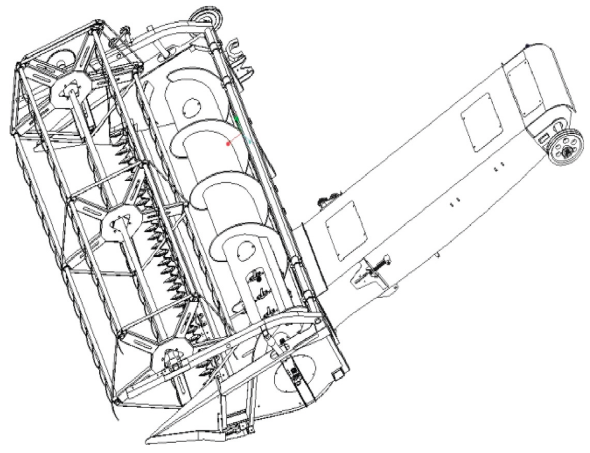
Figure 7: Assembly of the front